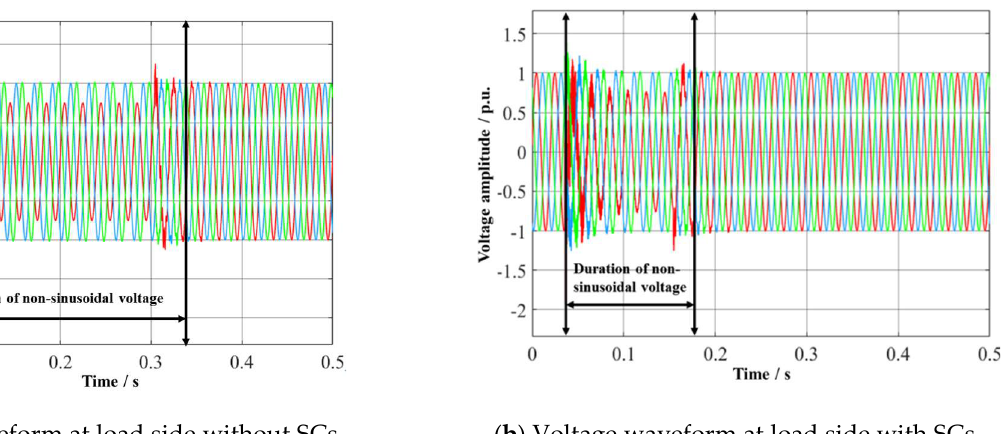
Figure 8. Comparison of three-phase non-sinusoidal duration of load voltage. Table 3. Detailed fault information and results of dynamic var reserve assessment in case study.